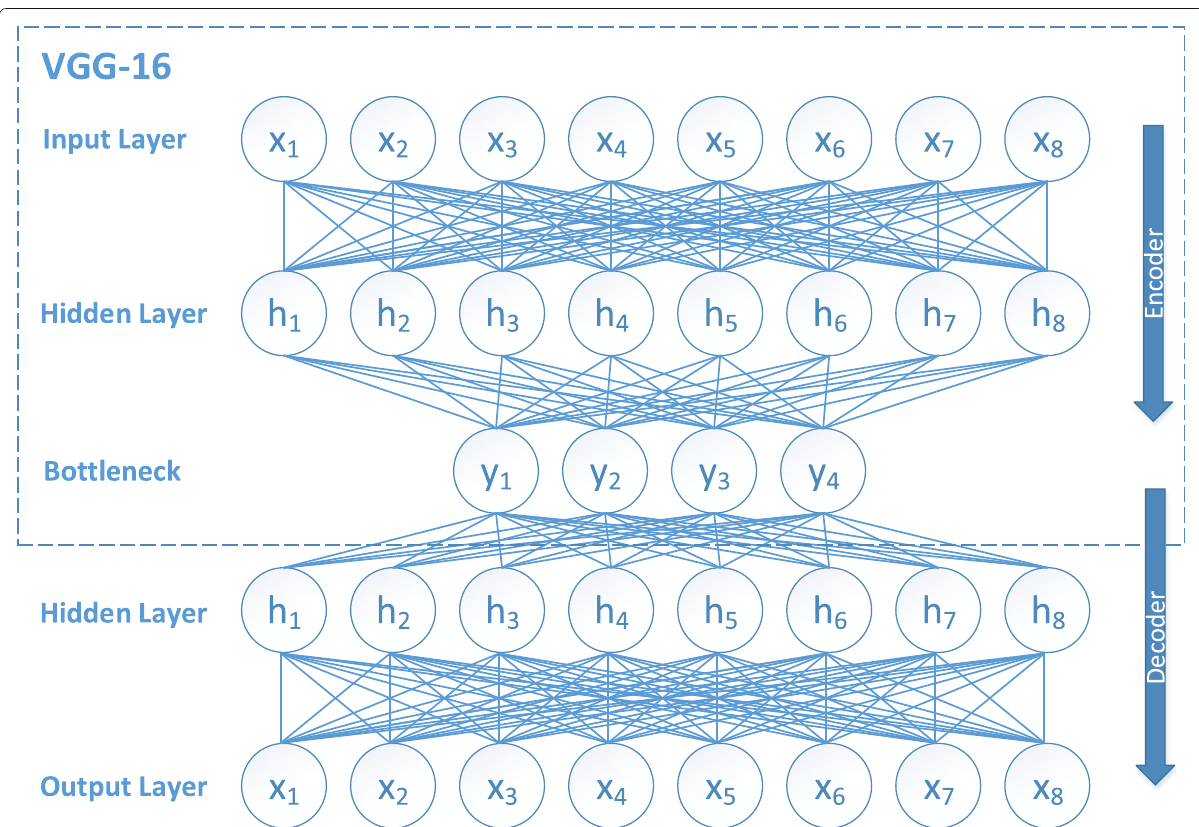
Fig. 4 Fine tuning. The reconstruction of VGG-16 to make an autoencoder for